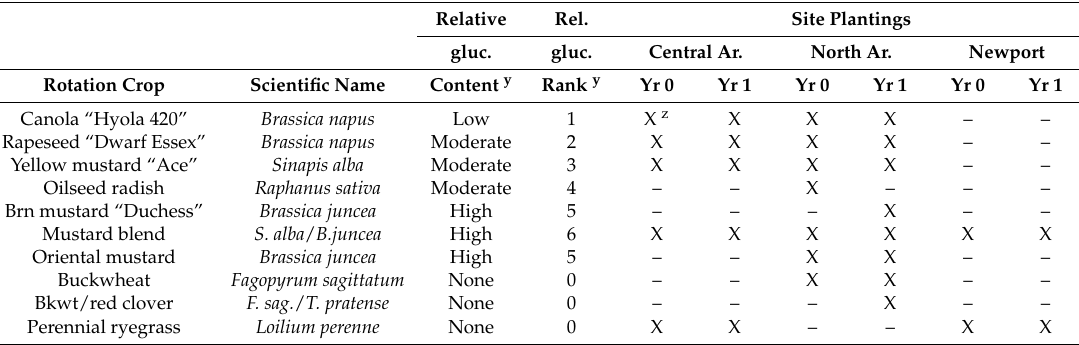
Table 1. Rotation crops evaluated for effects on soilborne potato diseases and yield at Central and Northern Aroostook and Newport field